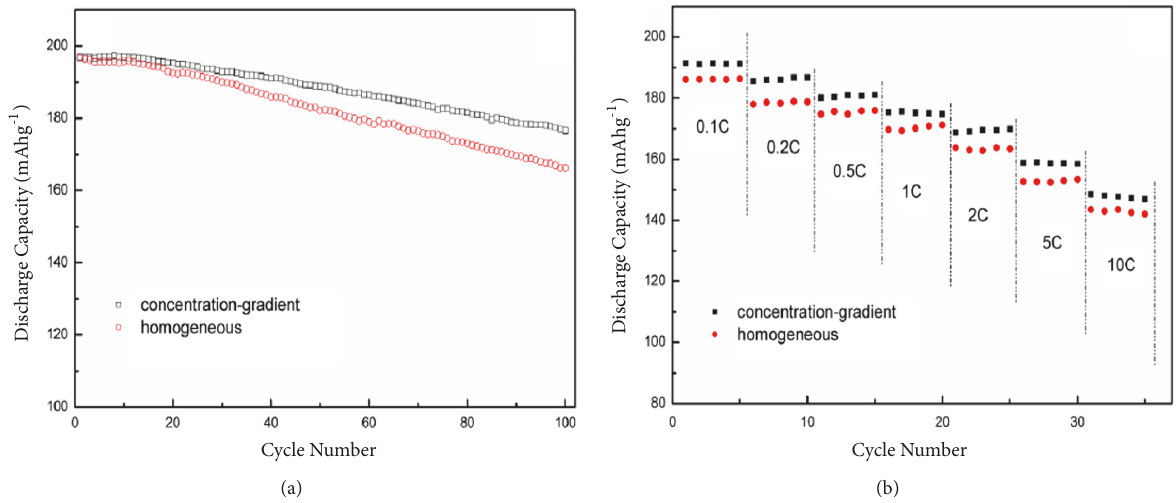
Figure 2: (a) Cycle performance and (b) rate capability of NCM622 with different synthetic methods [15]. Copyright: Journal of Alloys and Compounds,